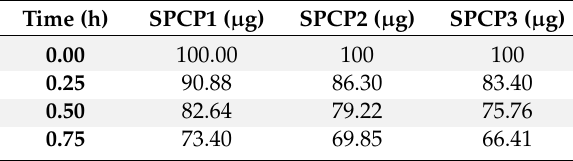
Table 2. The biodegradation test of SFCP microparticles in protease solution at 37 ◦